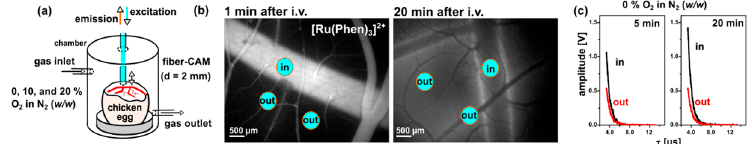
Figure 1. ( a ) Illustrative scheme of the gas chamber used to perform [Ru(Phen) 3 ] 2+ luminescence lifetime measurements in the CAM. ( b ) Fluorescence images of the CAM recorded 1 and 20 min after intravenous (iv) administration of [Ru(Phen) 3 ] 2+ (10 mg/kg of b.w.). ( c ) Illustrative outputs of [Ru(Phen) 3 ] 2+ (1 mg/kg of b.w.) luminescence lifetime detection at 0% O 2 in N 2 ( w / w ) atmosphere. The decays were detected in the blood vessels and out of the blood vessels as demonstrated in the fluorescence